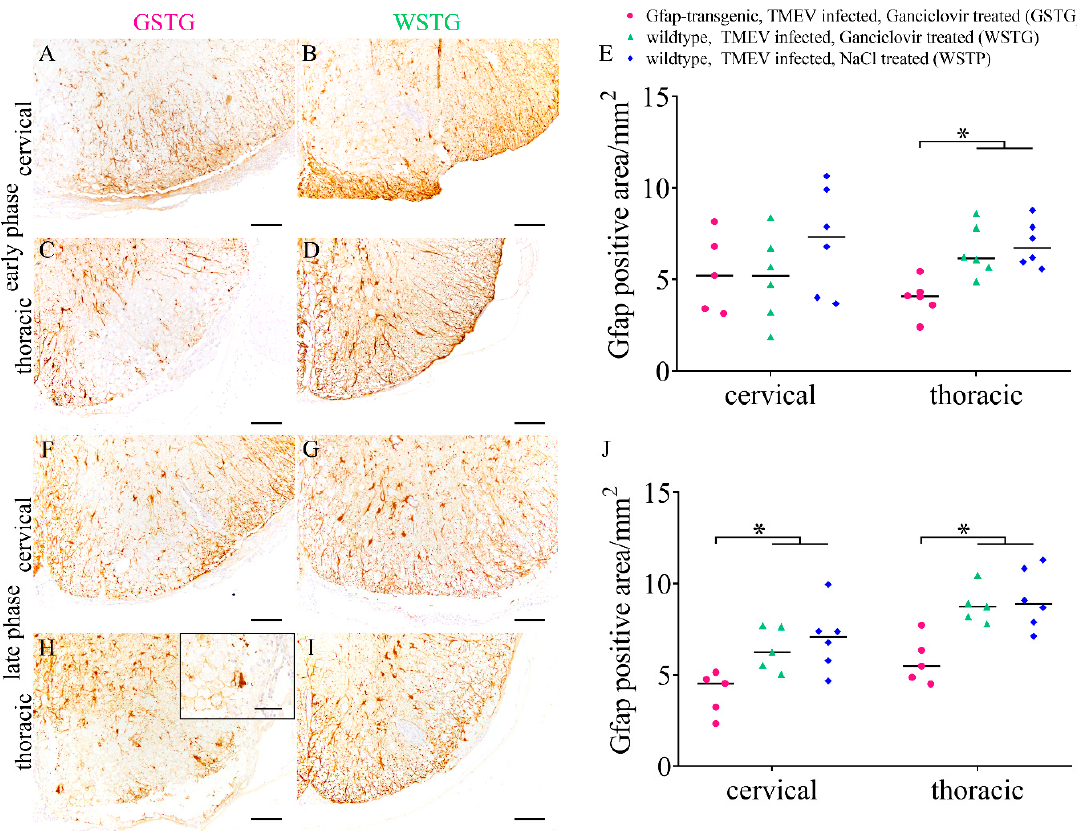
Figure 2. Astrocyte distribution during Theiler’s murine encephalomyelitis (TME). Immunohistochemistry targeting glial fibrillary acidic protein (GFAP) was used for the detection of astrocytes. At 46 days post infection (dpi; early phase) TMEV infected, ganciclovir treated, Gfap -transgenic mice showed a significantly reduced GFAP-positive area in the white matter of the thoracic spinal cord ( A , C ) compared to TMEV infected, ganciclovir treated wildtype (WSTG; B , D ) and TMEV infected, natrium chloride treated wildtype (WSTP; E ) mice. At 77 dpi (late phase) TMEV infected, ganciclovir treated, Gfap -transgenic mice showed a significantly reduced GFAP-positive area in the white matter of the cervical and thoracic spinal cord segment ( F , H ) compared with WSTG ( G , I ) and WSTP ( J ). Insert shows the morphology of an intralesional astrocyte in a GSTG animal ( H ). Data are shown as scatter dot plots. Significant differences between the groups obtained by Kruskal-Wallis test followed by Mann–Whitney U post hoc tests were indicated by *, p < 0.05. Bars represent 100 µm in overviews and 50 µm in the insert.